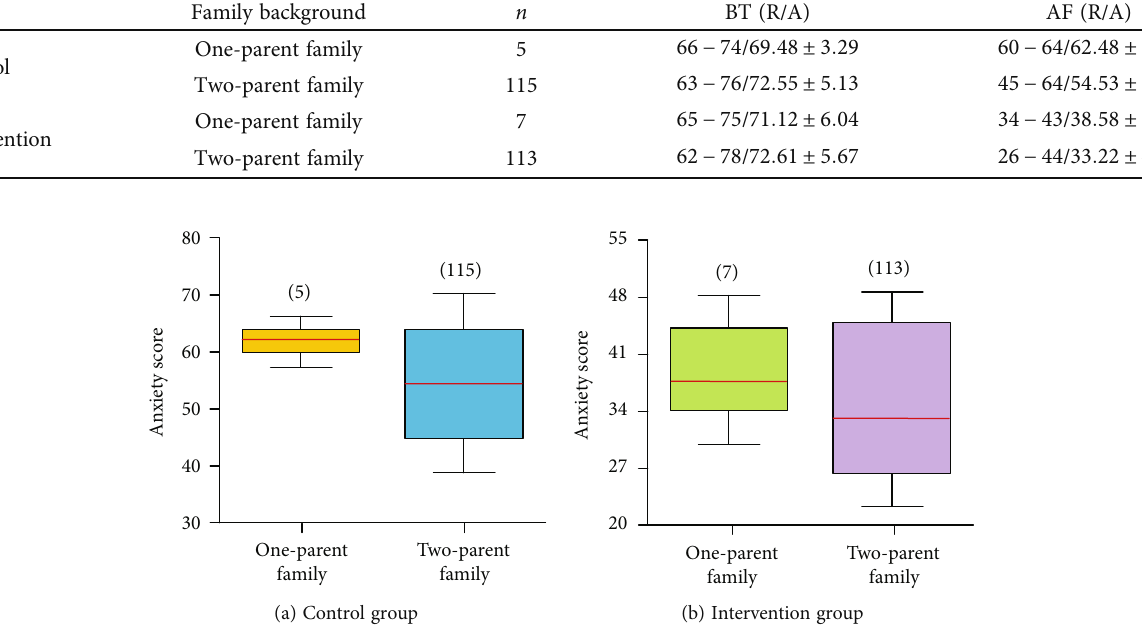
Figure 6: Anxiety evaluation results of college students with di ff erent family background in the control and intervention groups after